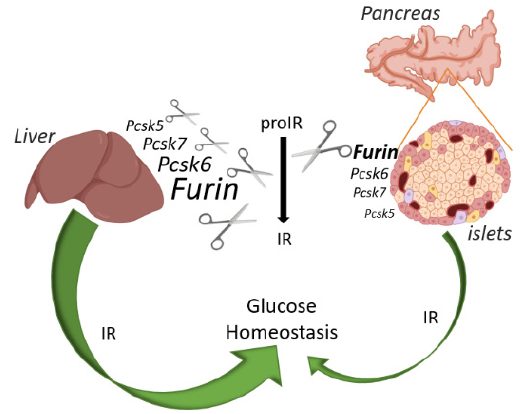
Figure 4. Schematic overview of the IR action on glucose and relative abundance of each PC in liver and pancreatic islets of mice. FURIN non-redundantly cleaves the proIR in pancreatic beta cells of mice, but the IR exerts only a minor effect on glucose homeostasis. In contrast, proprotein convertases other than FURIN can process proIR in the mouse liver, but here this receptor plays a pivotal role in glucose homeostasis. Image created with BioRender.com.